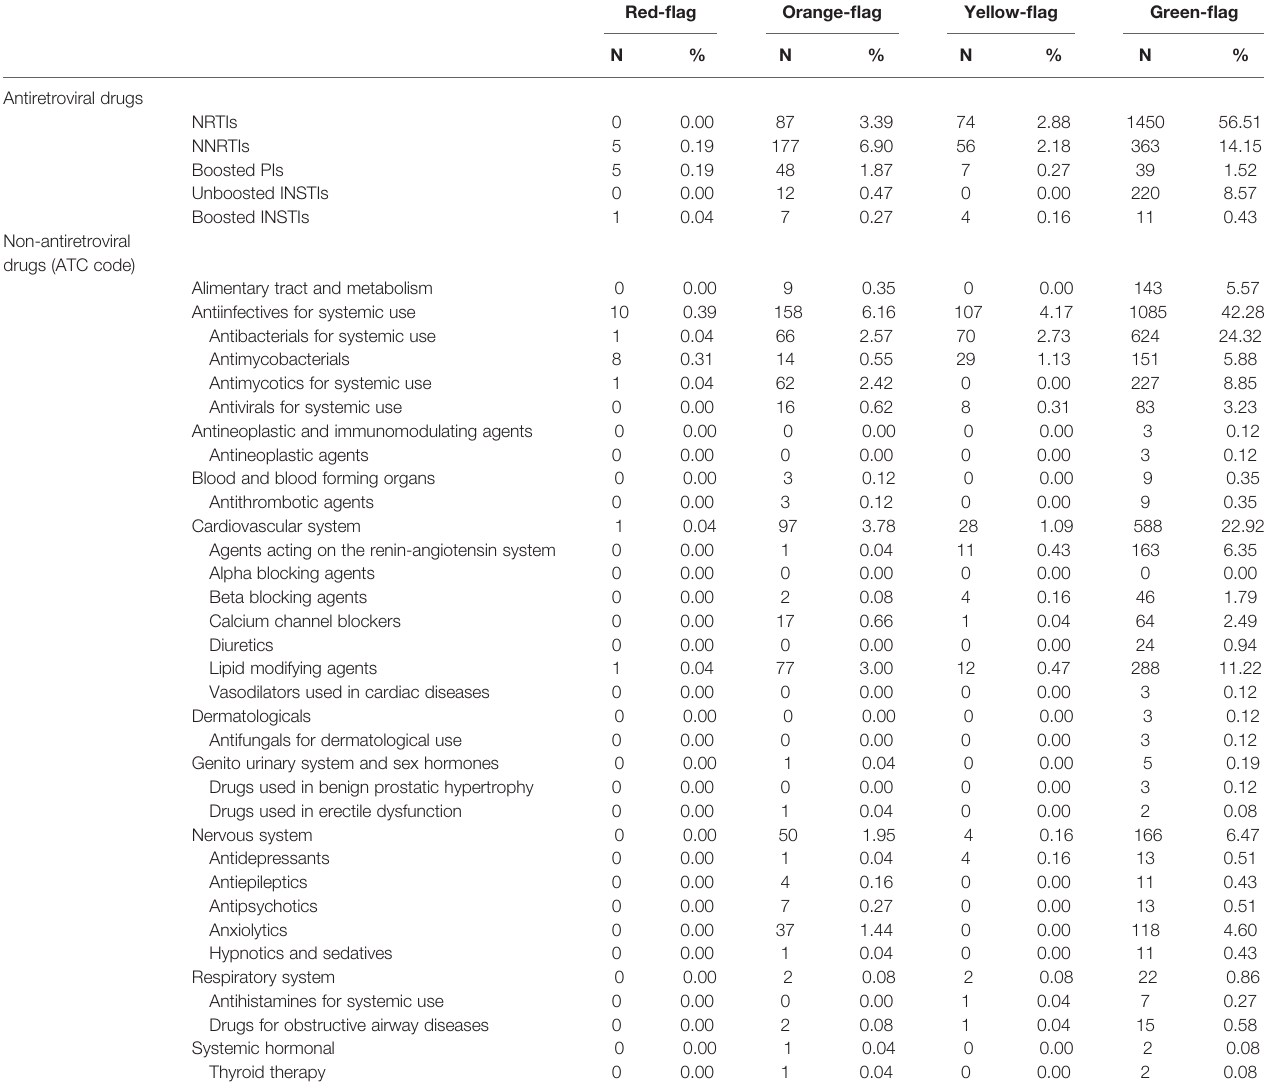
TABLE 2 | Prevalence of potential drug-drug interactions according to antiretroviral and non-antiretroviral medications in people living with HIV.